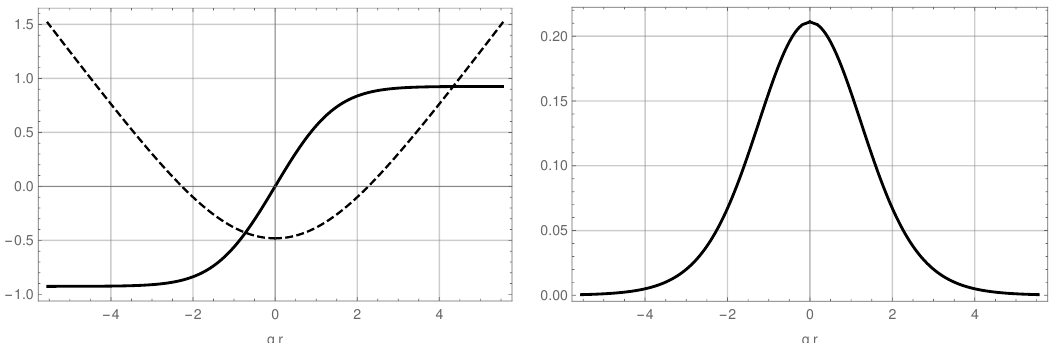
Figure 4. A sample solution with I = 4 = 5 . On the left pane we plot the functions 2( F ( r ) (cid:0) F 0 ) (solid curve) that controls the solution for ’ and X (cid:0) 1 (dashed curve) which is just a constant shift of the warp factor A . On the right pane we plot sinh (cid:31)